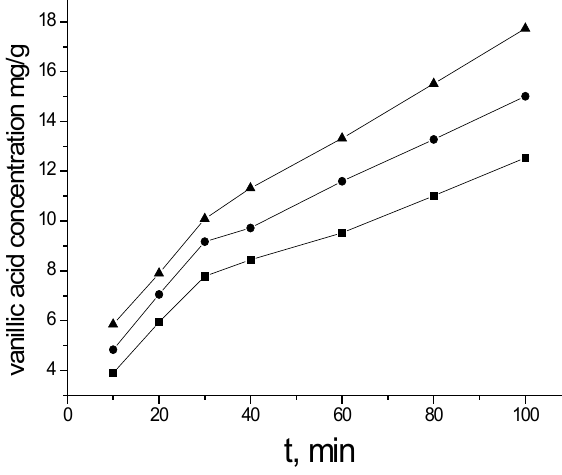
Figure 1: Variation of the vanillic acid concentration in liquid extracts during the extraction process at ( 45±0.1°C.